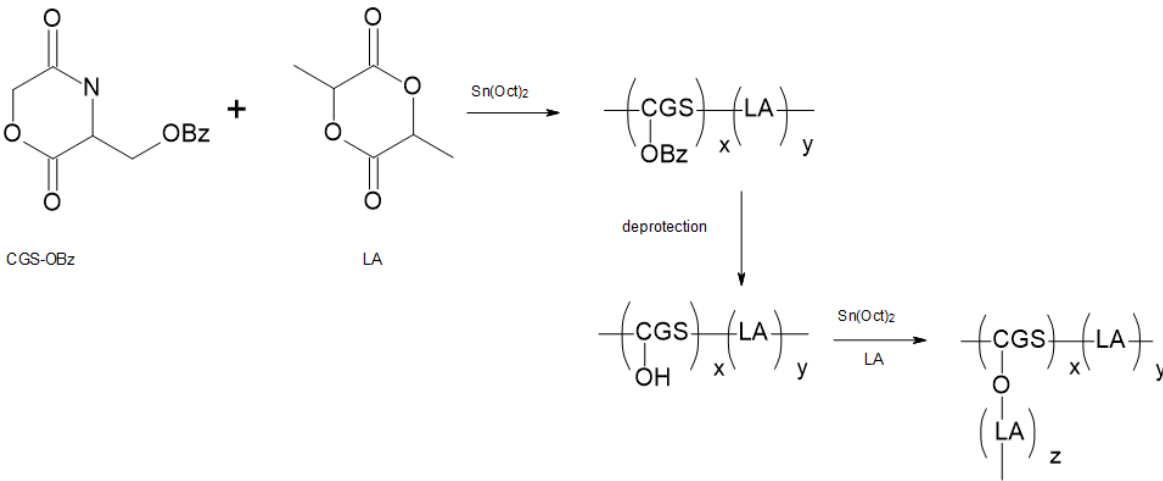
Figure 24. Synthesis of graft polymer PLA onto poly(LA/CGS-OBz) by the generation of initiating groups and the “grafting from” method [86].